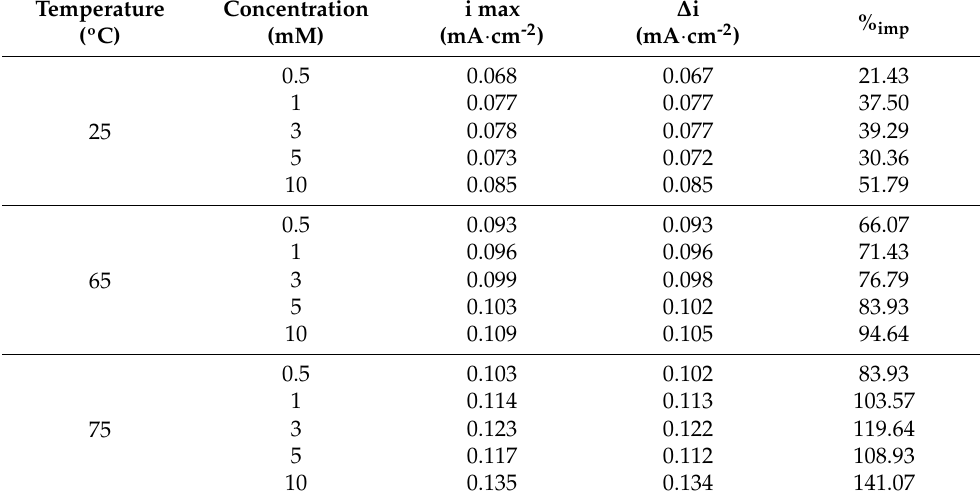
Table 1. Current density at 0.6 V Ag/AgCl under illuminated conditions (i max ), increase in current density at 0.6 V Ag/AgCl between dark and light conditions ( ∆ i), and percentage improvement in current density at 0.6 V Ag/AgCl under illumination (% imp ) with respect to the TiO 2 nanosponges, for TiO 2 /ZnO hybrid nanosponges electrodeposited on crystalline TiO 2 for 15 min. Temperature Concentration (ºC) (mM) (mA · cm -2